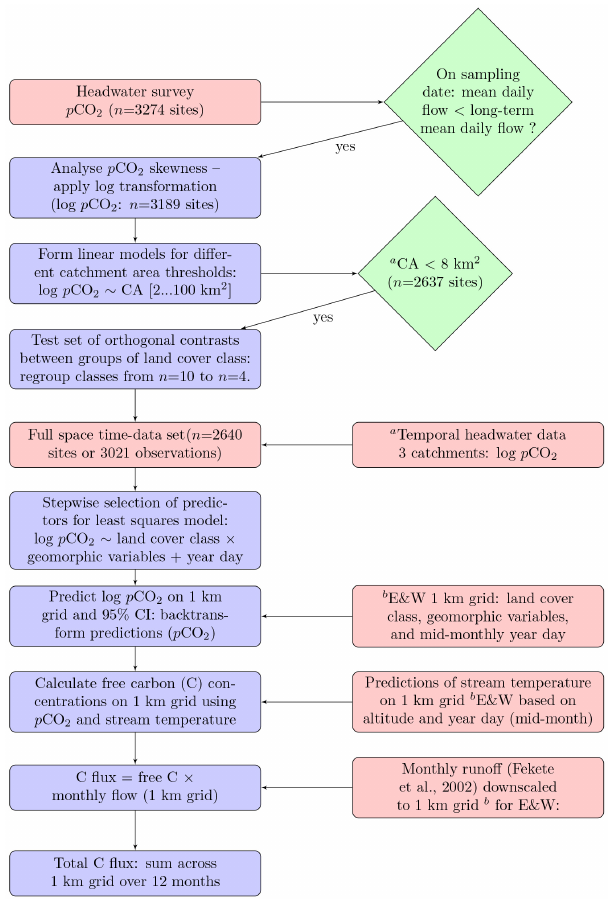
Fig. 2. Flow diagram showing stages in the development and ap- plication of a model to predict potential C (CO 2 ) fluxes from sur- face water across England and Wales. Red boxes=data sets, green boxes=data selection, blue boxes=computations. a see supplemen- tary file for exploratory analysis; b England and